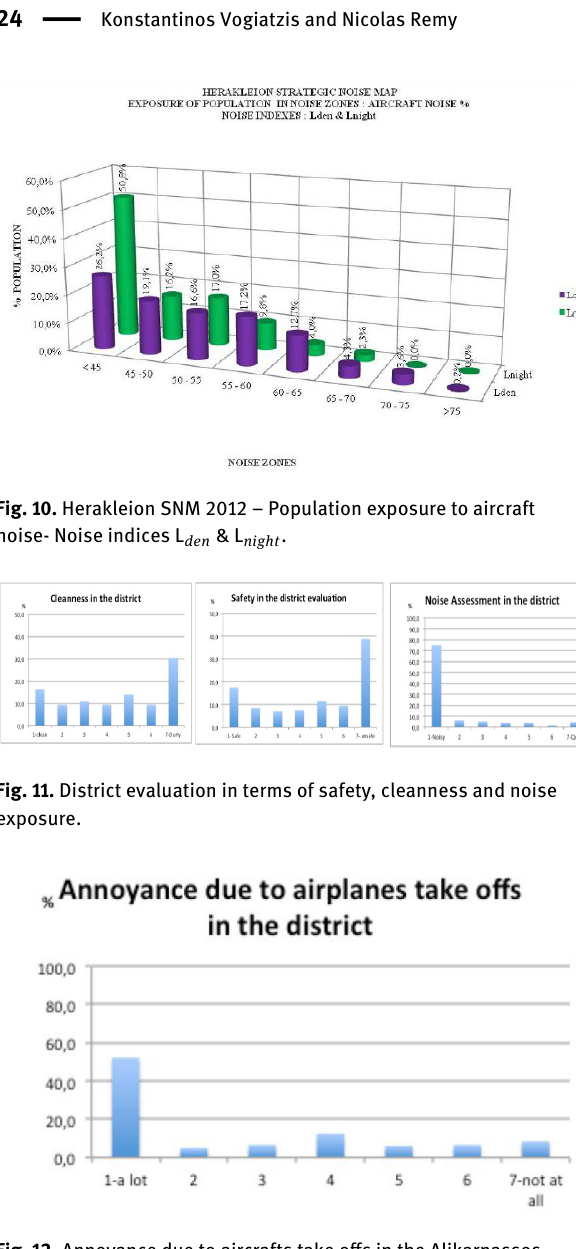
Fig. 12. Annoyance due to aircrafts take offs in the Alikarnassos district.